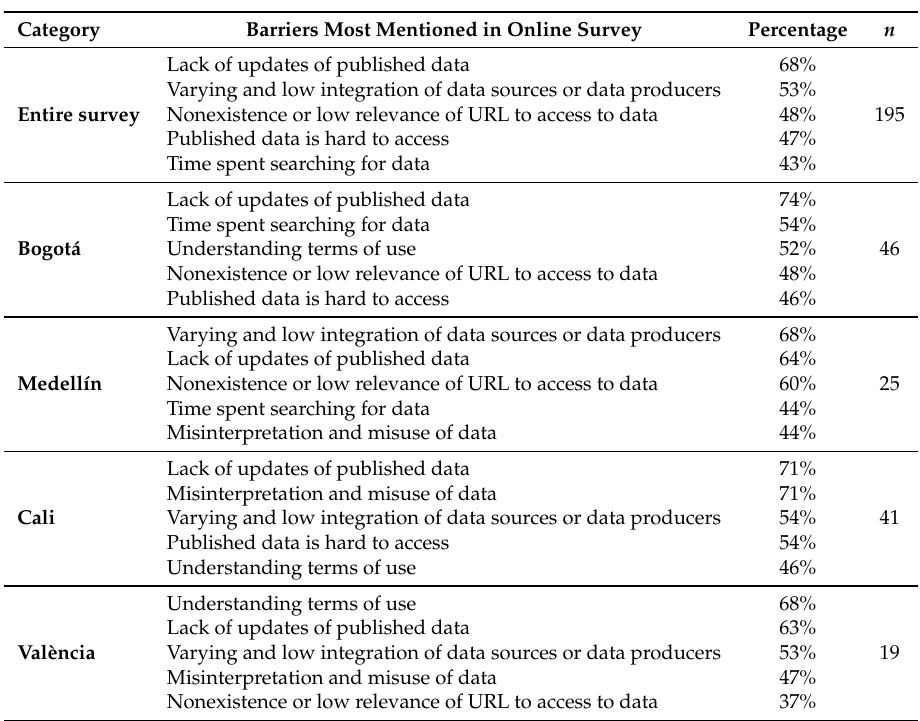
Table 5. Top five of barriers mentioned by data users along the online survey first question, for the entire sample and also group by each selected city.